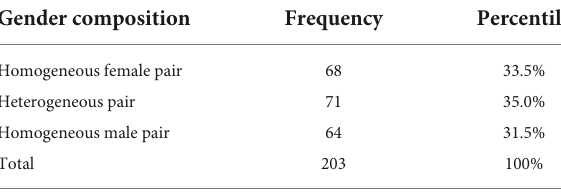
TABLE 2 Distribution of filmed pairs by gender